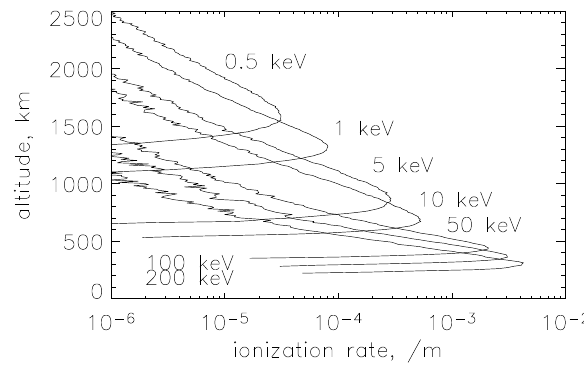
Figure 1: 2007.12.18: Y. Hiraki and C. Tao Fig. 1. Altitude distribution of ionization rate q ion per electron with